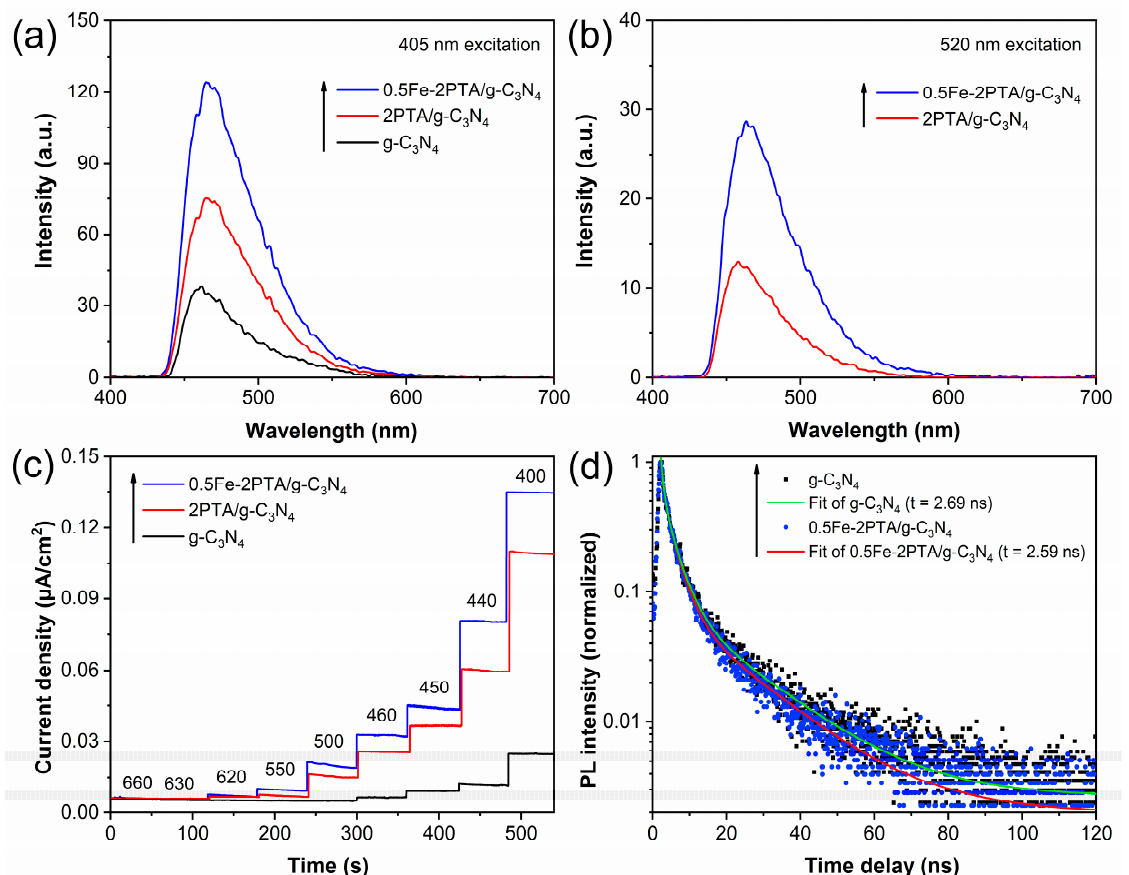
Figure 7. Fluorescence spectra related to the formed •OH amounts ( a ) at 405 nm excitation wave- length and ( b ) at 520 nm excitation wavelength. ( c ) Single-wavelength photocurrent action spectra under di ff erent excitation wavelengths. ( d ) TR-PL spectra excited under 369 nm.